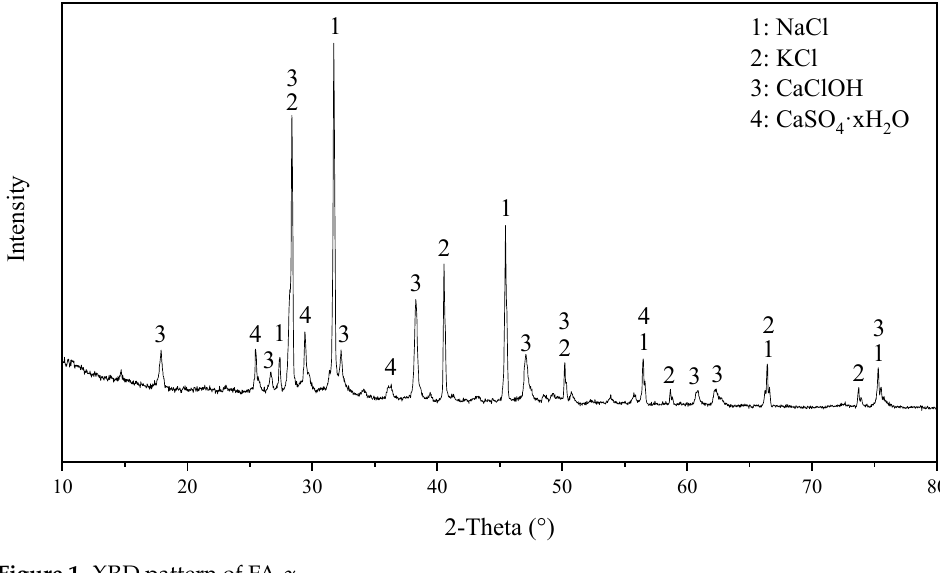
Figure 1. XRD pattern of FA α .